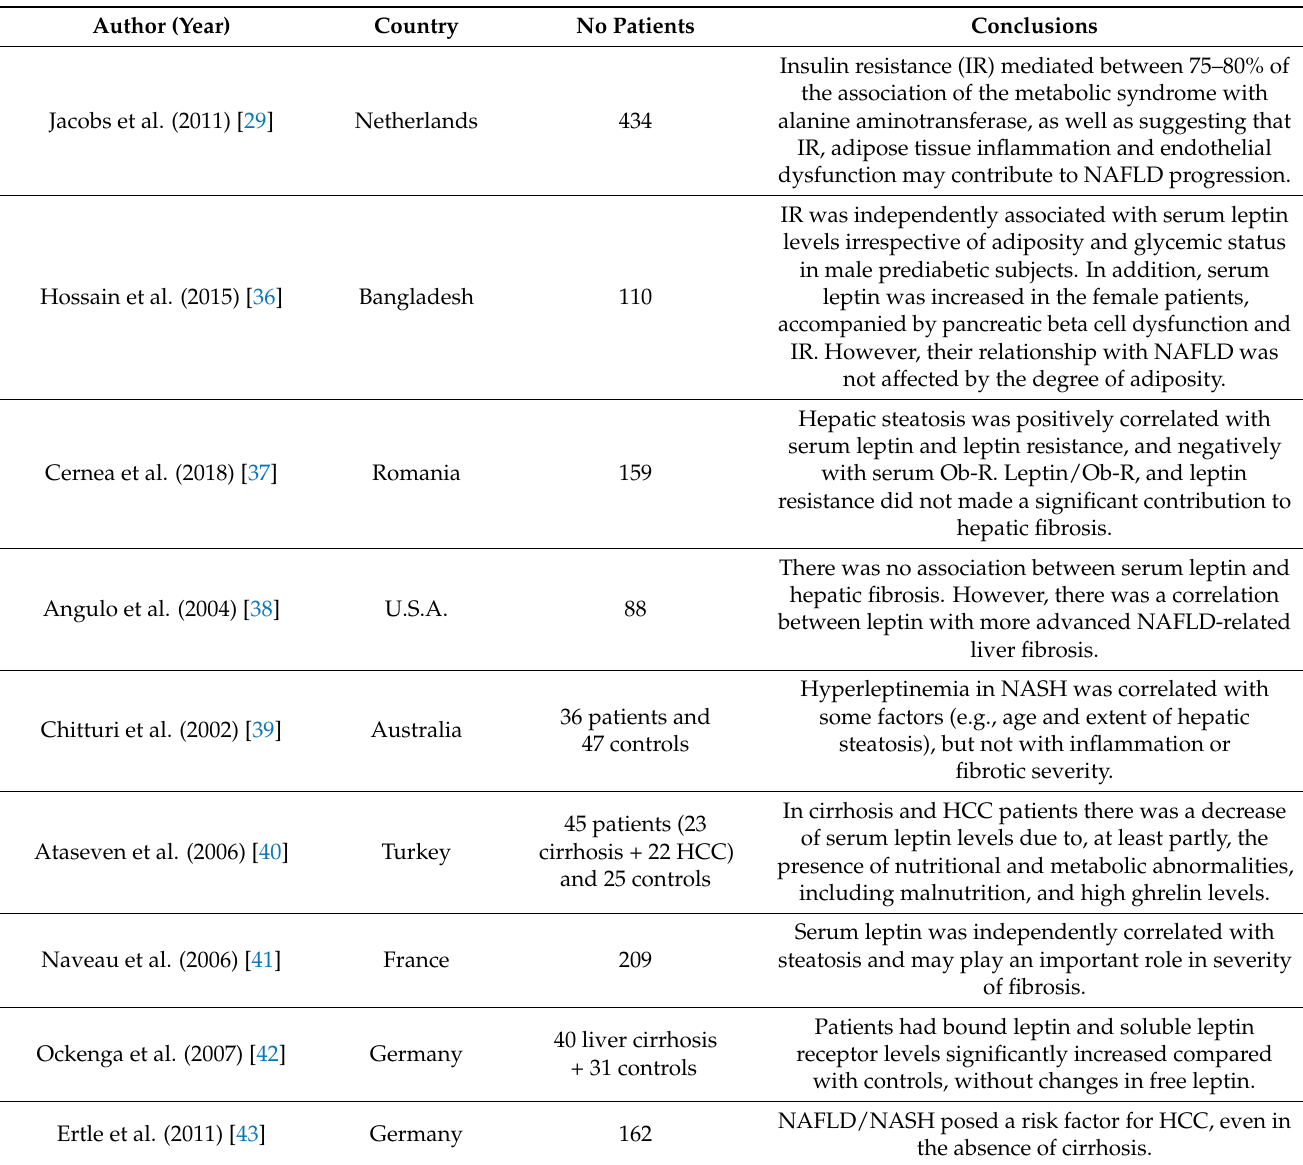
Table 1. Overview about reviewed research articles in human non-alcoholic fatty liver disease (NAFLD)